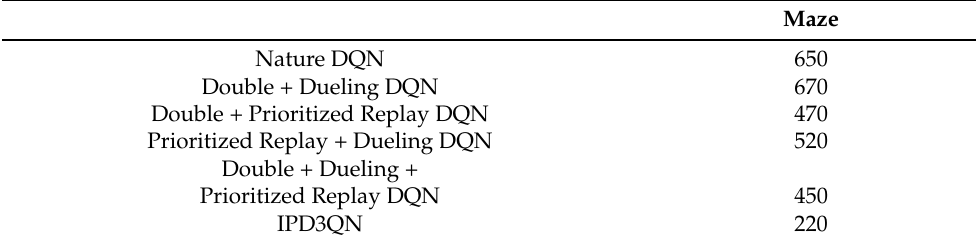
Table 6. Comparison Of Convergence Speed In Maze Environments.